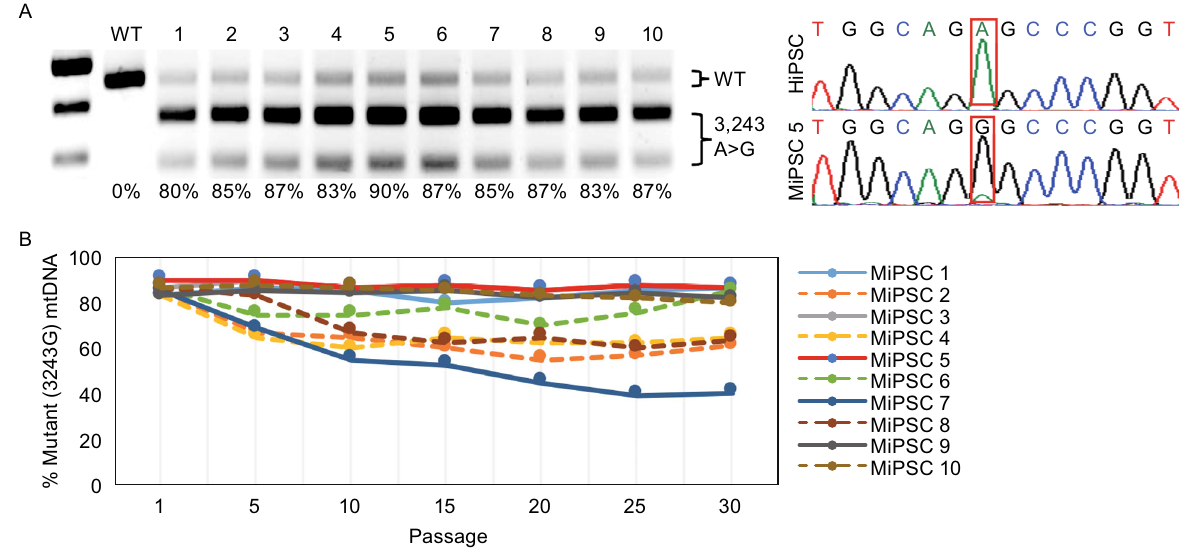
Figure 1. Derivation and characterization of MELAS patient-speci fi c iPSCs harboring a mtDNA 3243A>G mutation. (A) MELAS patient-speci fi c iPSC (MiPSC) lines were established that harbored high 3243A>G heteroplasmy levels (>80%). The mtDNA 3243A>G mutation rate was determined by RFLP analysis and Sanger sequencing. An iPSC line derived from healthy human fi broblasts (HiPSC) was used as the control. (B) The MiPSC lines maintained high 3243A>G heteroplasmy levels after long-term culture. The 3243A>G heteroplasmy levels were assessed in MiPSC lines every 5 passages from passage 1 to passage